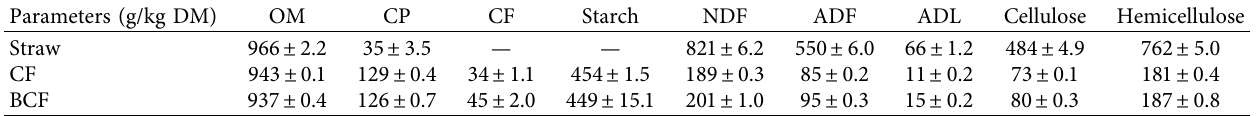
Table 1: Chemical composition of the feeds used in this